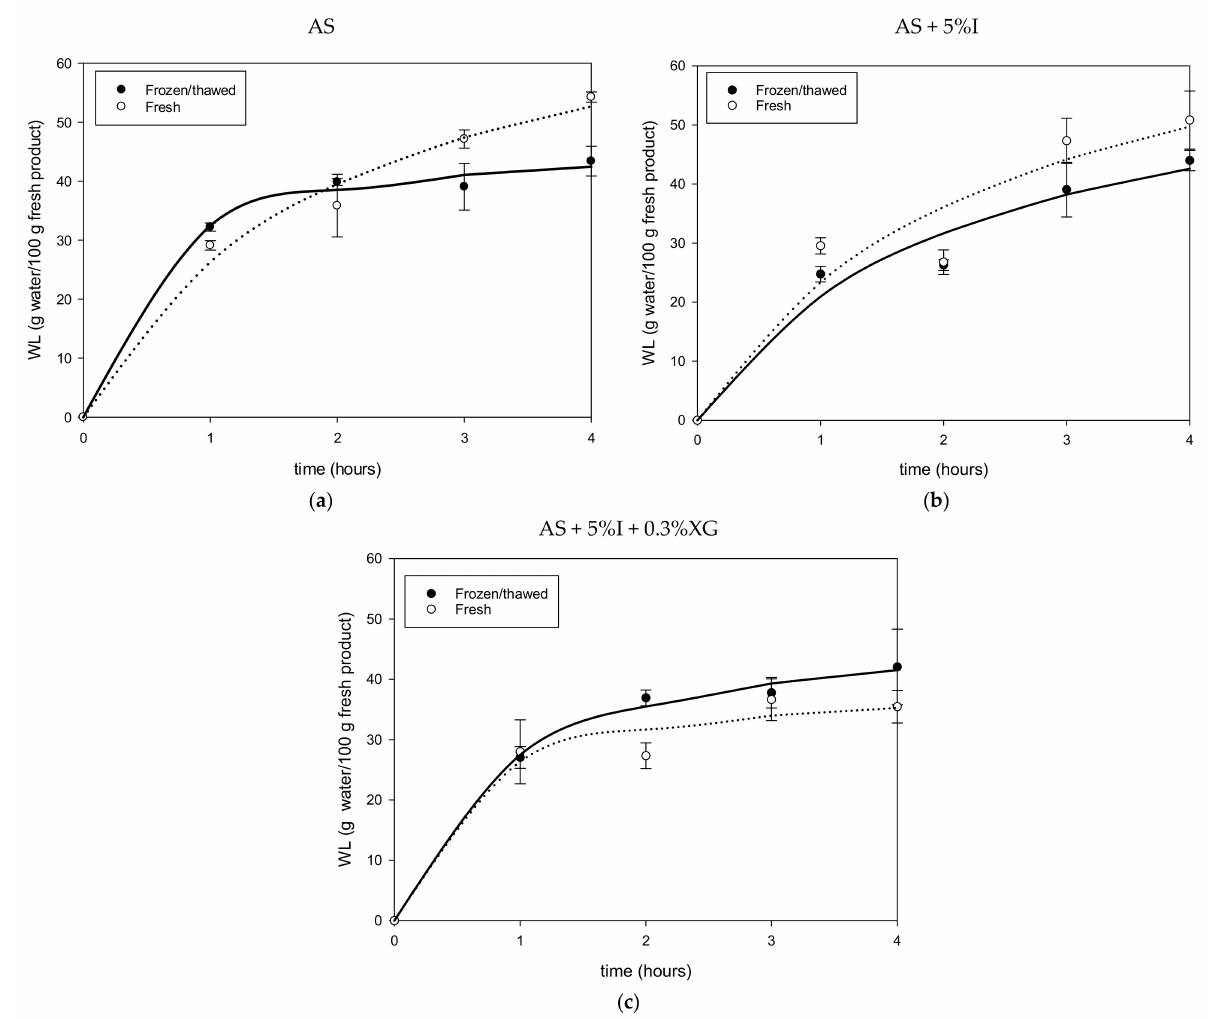
Figure 1. Water loss of Fresh and F-T mango during osmotic dehydration in AS ( a ), AS + %I ( b ) and AS + %I + 0.3%XG ( c )